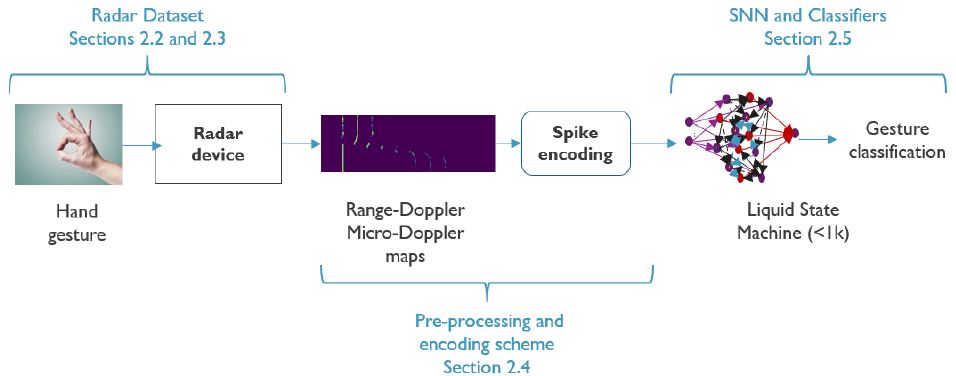
Figure 1. Pipeline of the radar-based hand gesture recognition system, from the dataset to the end classification, indicating the respective sections that detail each of the steps. The SNN and Classifier diagram is detailed in Section